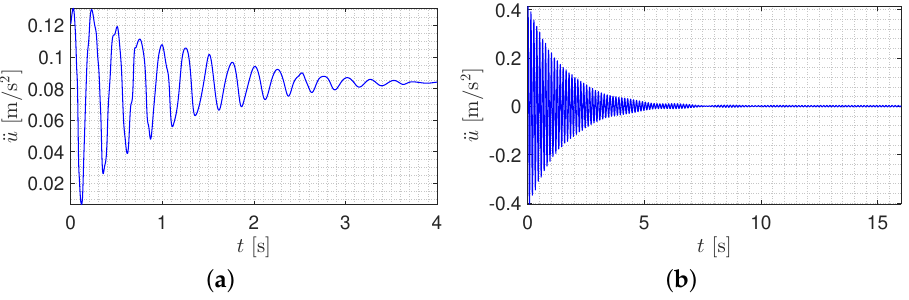
Figure 10. Free vibration response obtained for sensor #5. ( a ) 0–4 s time frame; ( b ) 0–16 s time